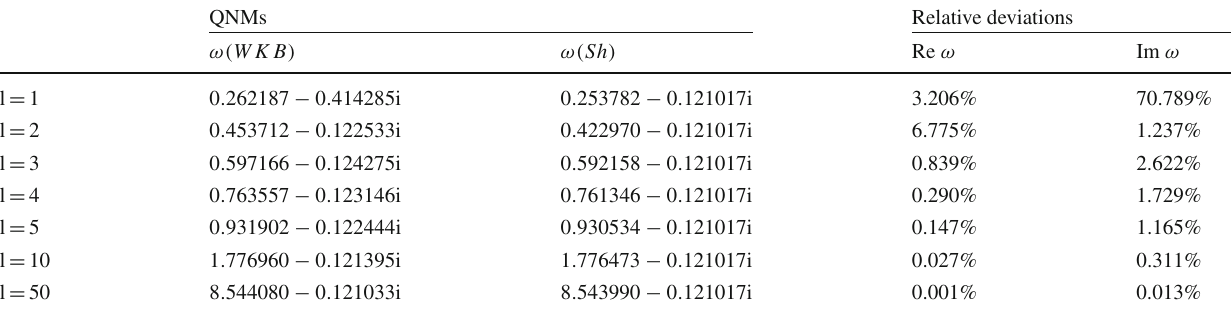
Table 5 The QNMs derived by the WKB approximation approach and shadow radius and the relative deviations. In the calculation, we let Q = 0 . 4